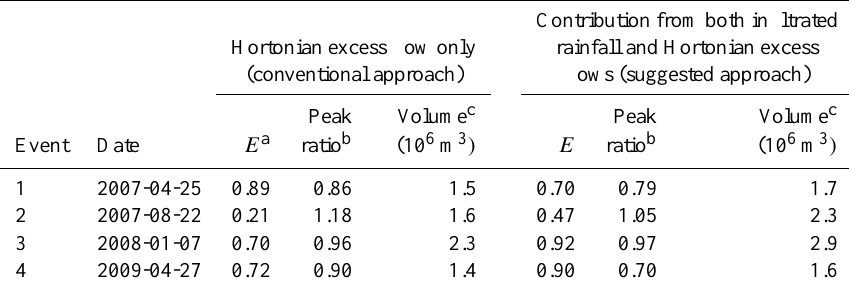
Table 5. Comparison between a runoff hydrograph considering contribution from impervious areas only and one that considers contribution from both pervious and impervious areas.